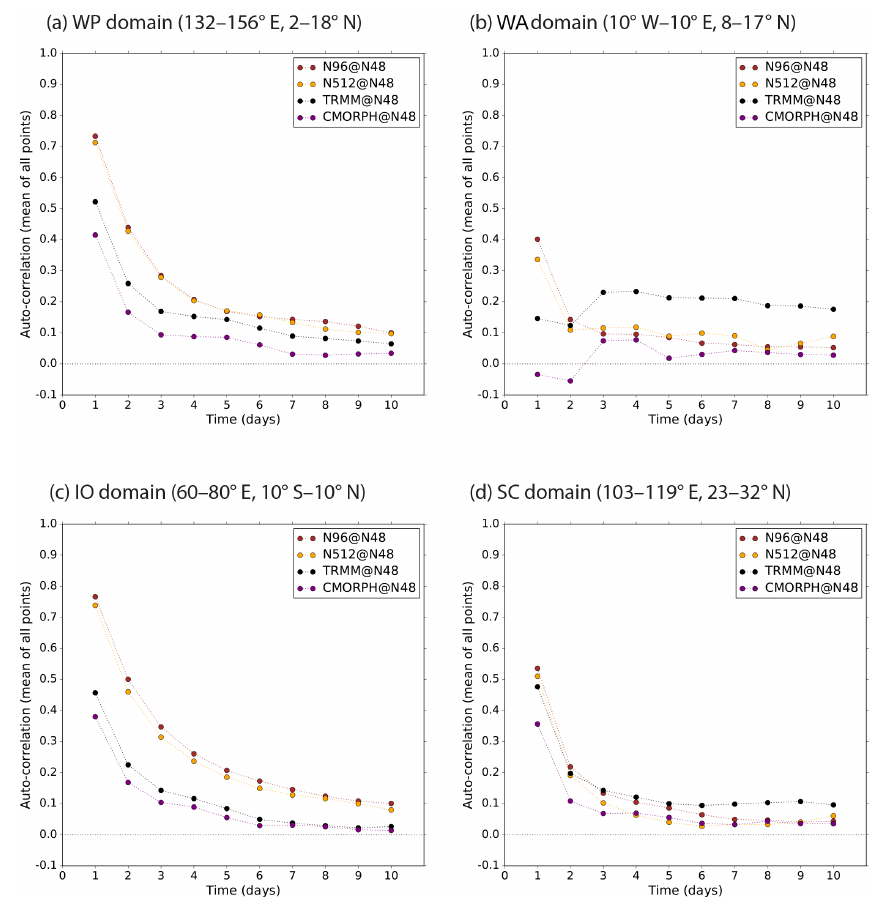
Figure 11. Auto-correlations of precipitation at different time lags, computed using daily precipitation on the N48 horizontal grid, averaged over the four regions shown in Fig.